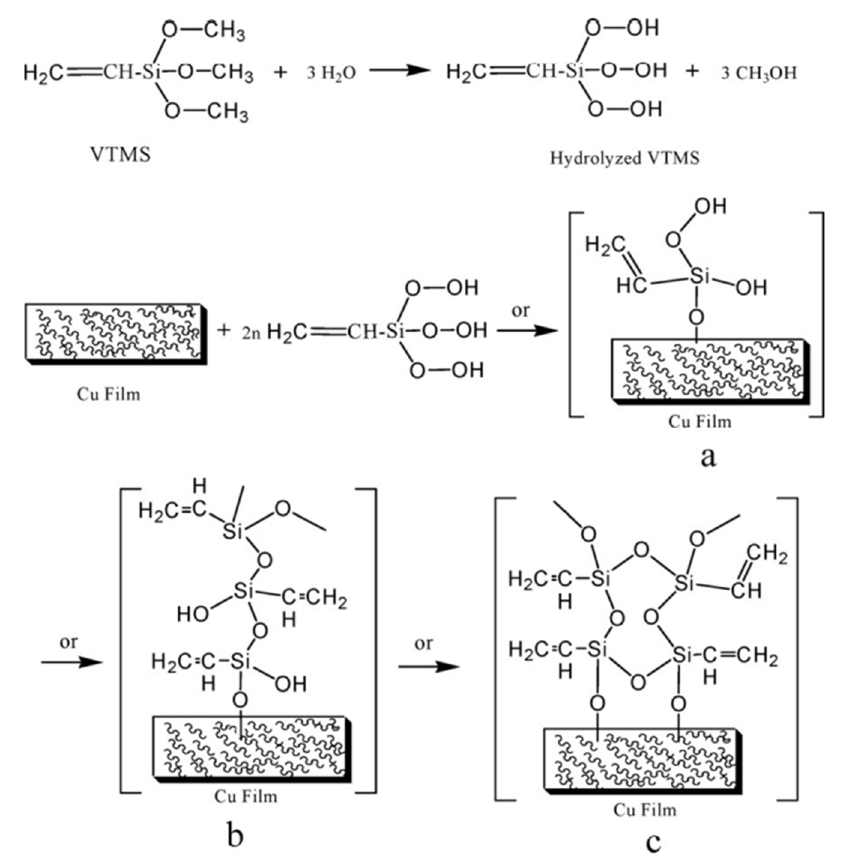
Figure 12. Schematic illustration of the formation of the superhydrophobic film on the copper interface. ( a ) The condensation reaction between the oxidized copper surface and silanol. ( b ) The horizontal condensation reaction among silanols. ( c ) The form of grafted polysiloxane. Reprinted with permission from Ref [66]. Copyright 2012 Elsevier.